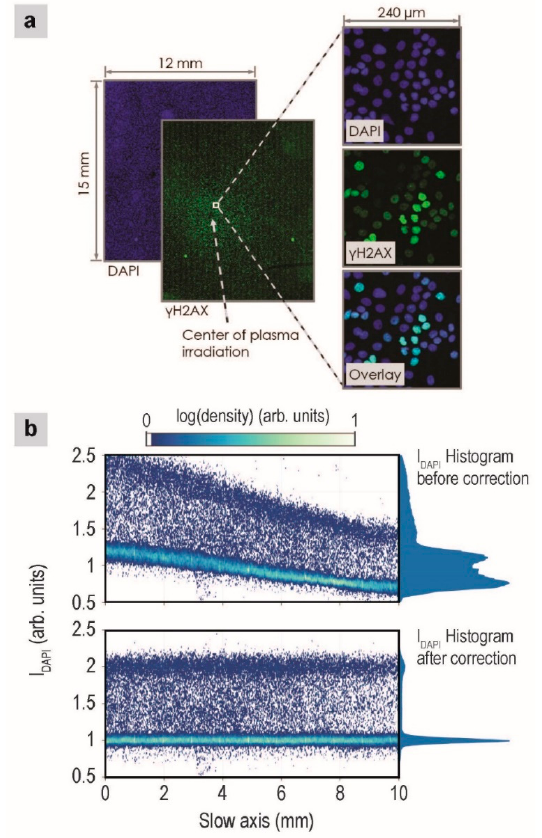
Figure 1. ( a ) Representative fluorescence images of cells, after 2-min plasma treatment and 1-h incubation. Green and blue fluorescence signals correspond to γ H2AX and DAPI, respectively. ( b ) Effects of background correction. Plots show the nuclear DAPI intensity along the slow axis of the fluorescence slide scanner. Colors encode the nuclear density (along the slide scanner’s fast axis). A histogram of the nuclear DAPI intensity is indicated to the right of each plot. The top and bottom plots show data before background correction and after flattening and stripe artifact removal,